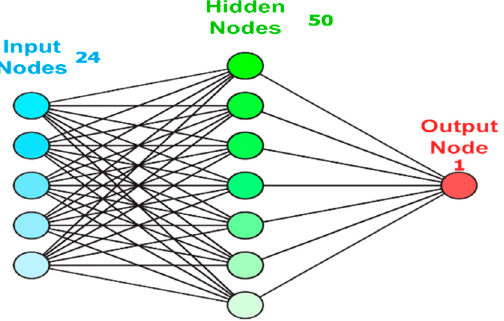
Figure 6. Schematic view of input, hidden layer, and output.